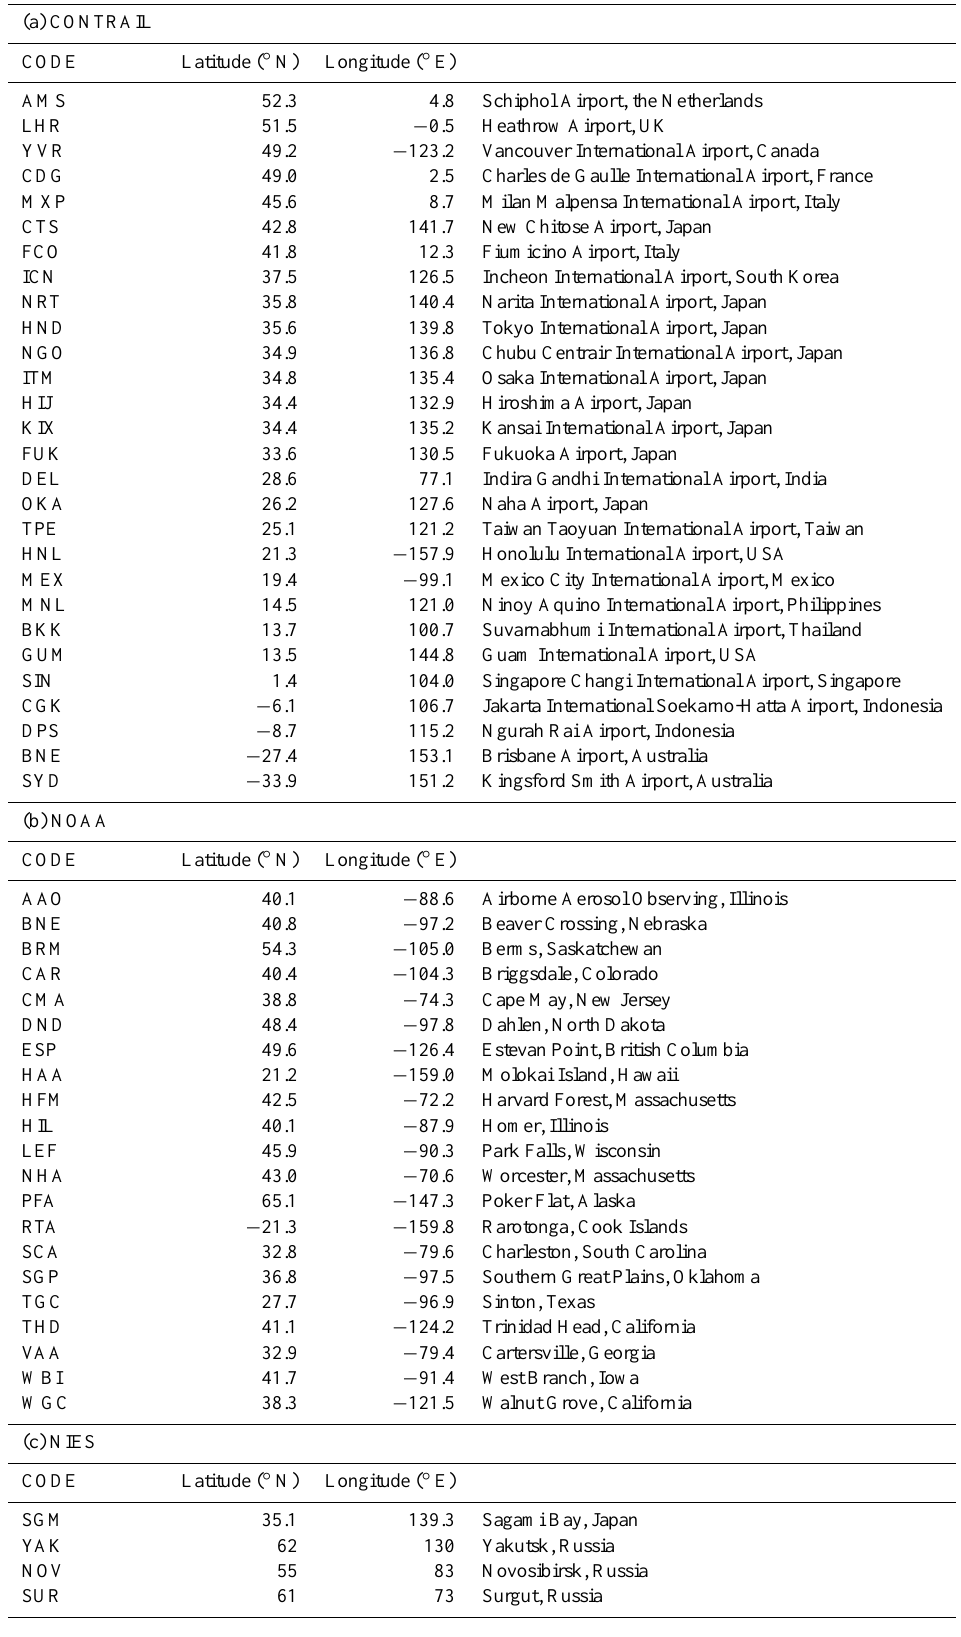
Table 1. Locations of the sites where aircraft measurements were